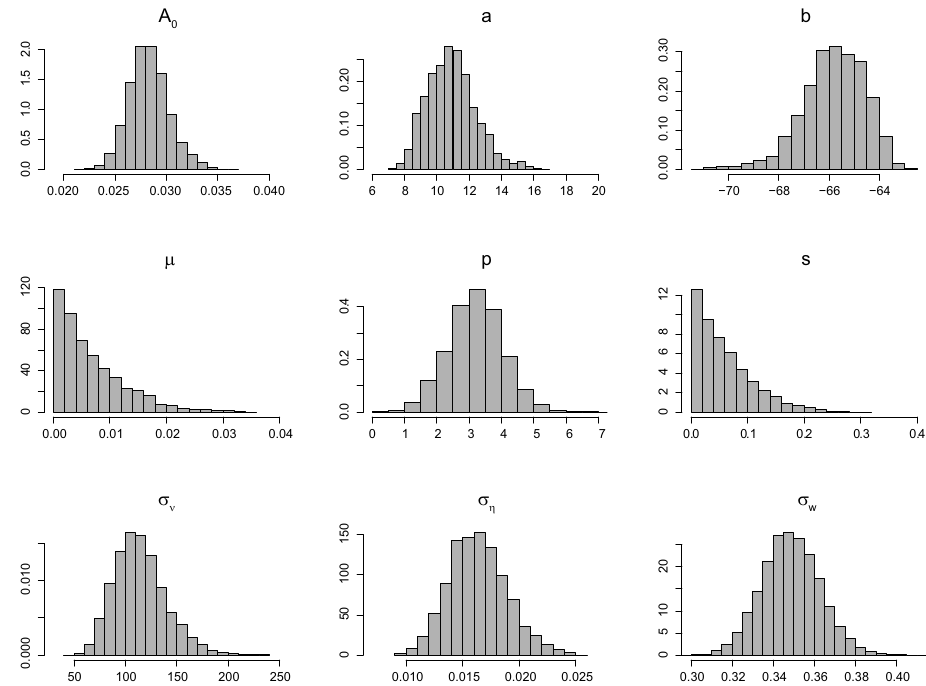
Figure 2. Estimated marginal distributions of the posterior distributions for the nine